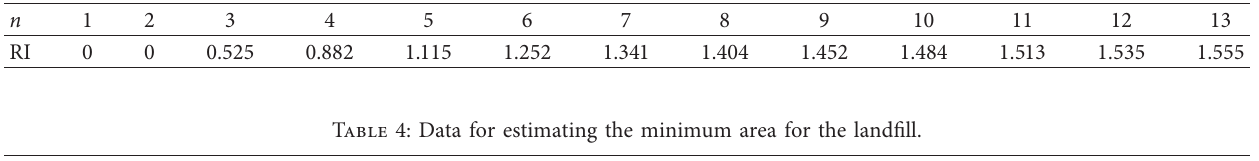
Table 3: Value of the random index for each “ n ”.